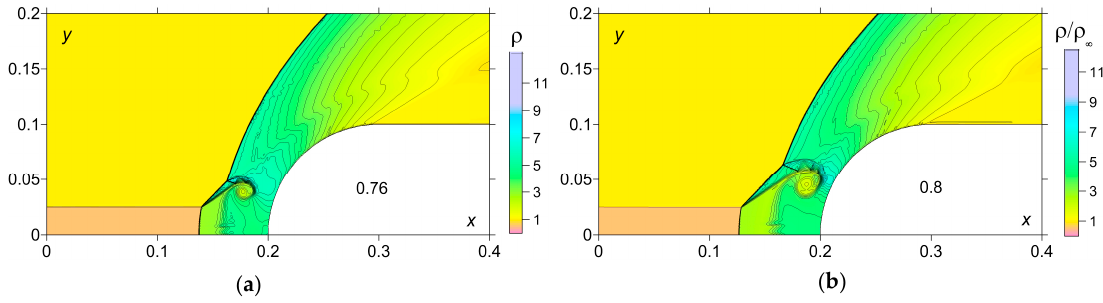
Figure 2. Self-similar mode of dynamics of triple-shock configuration and vortex-contact structure. Density (colors and isochors), γ = 1.2, α ρ = 0.5: ( a ) t = 0.76; ( b ) t = 0.8.